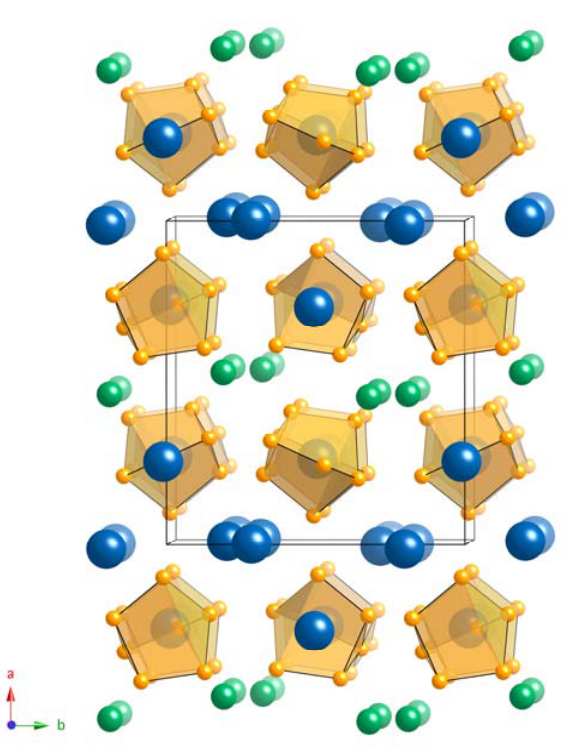
Figure 1. A schematic presentation of the crystal structure of Cs orange; Cs—dark blue; Na—green. The [As representation. The structure is projected approximately down the c -axis and the unit cell is